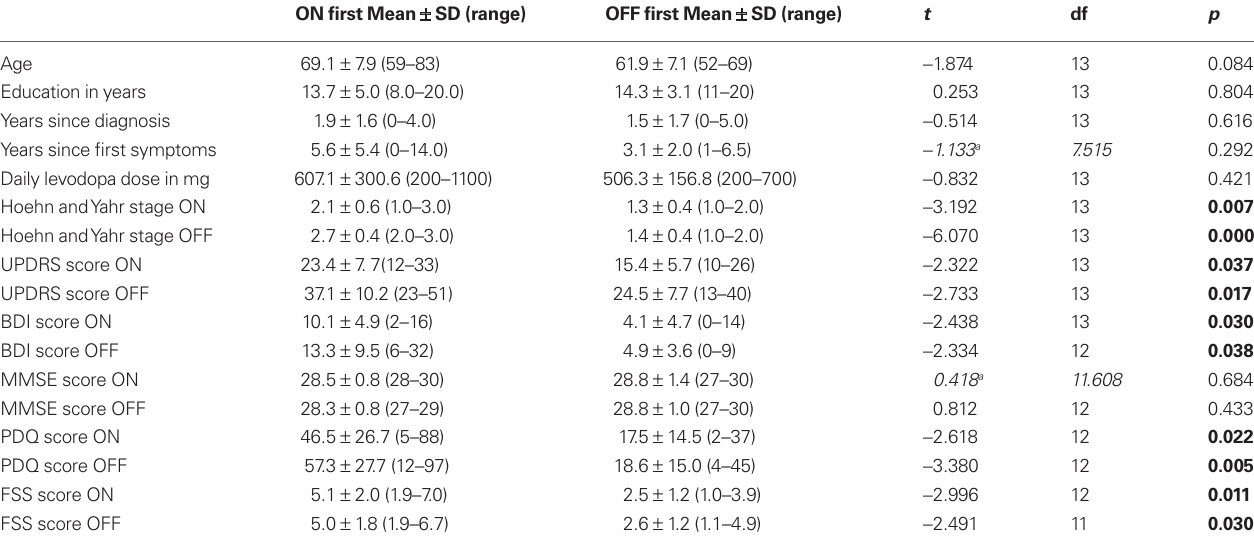
Table 2 | Group characteristics for ON-beginner and OFF-beginner